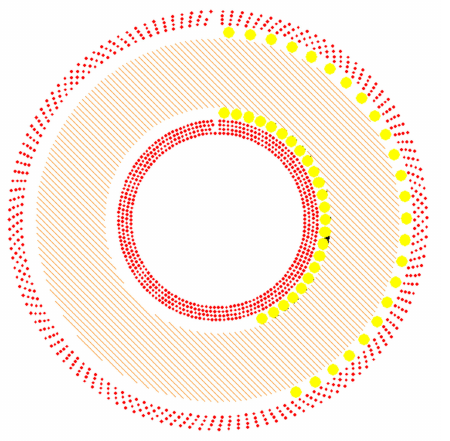
Figure 17. 2D Toroidal Transformer ( N P = 24 & N S =